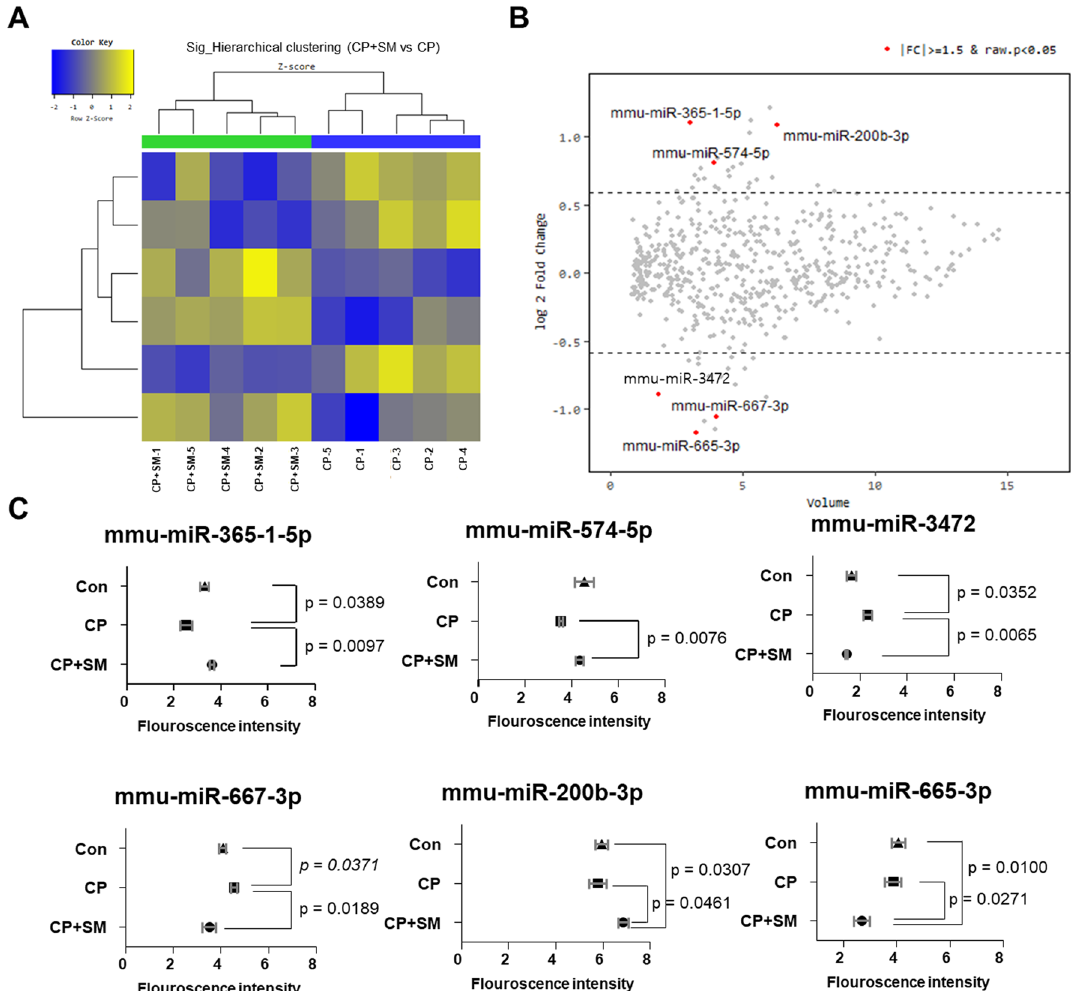
Figure 8. Hierarchical clustering and analysis of differentially expressed microRNAs. Microarray analysis was performed to compare the microRNA expression in ovulated ovaries of the CP and CP + SM mice. ( A ) Hierarchical clustering among the microRNA expression profiles. ( B ) Volume plot of log2 fold changes between the CP and CP + SM mice, showing six significantly differentially expressed microRNAs with fold changes > 1.5 and P < 0.05. ( C ) Microarray fluorescence intensities indicate the expression levels of miR-365-1-5p, miR- 3472, miR-200b-3p, miR-665-3p, miR-667-3p, and miR-574-5p in the Con, CP, and CP + SM mice.